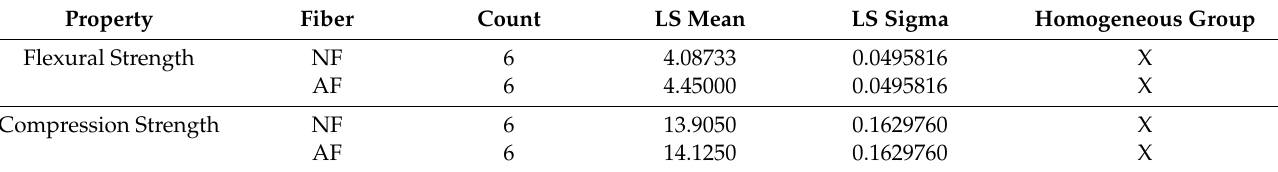
Table 9. Multi-range test for flexural and compressive mechanical strengths (MPa) considering the incorporation of aramid